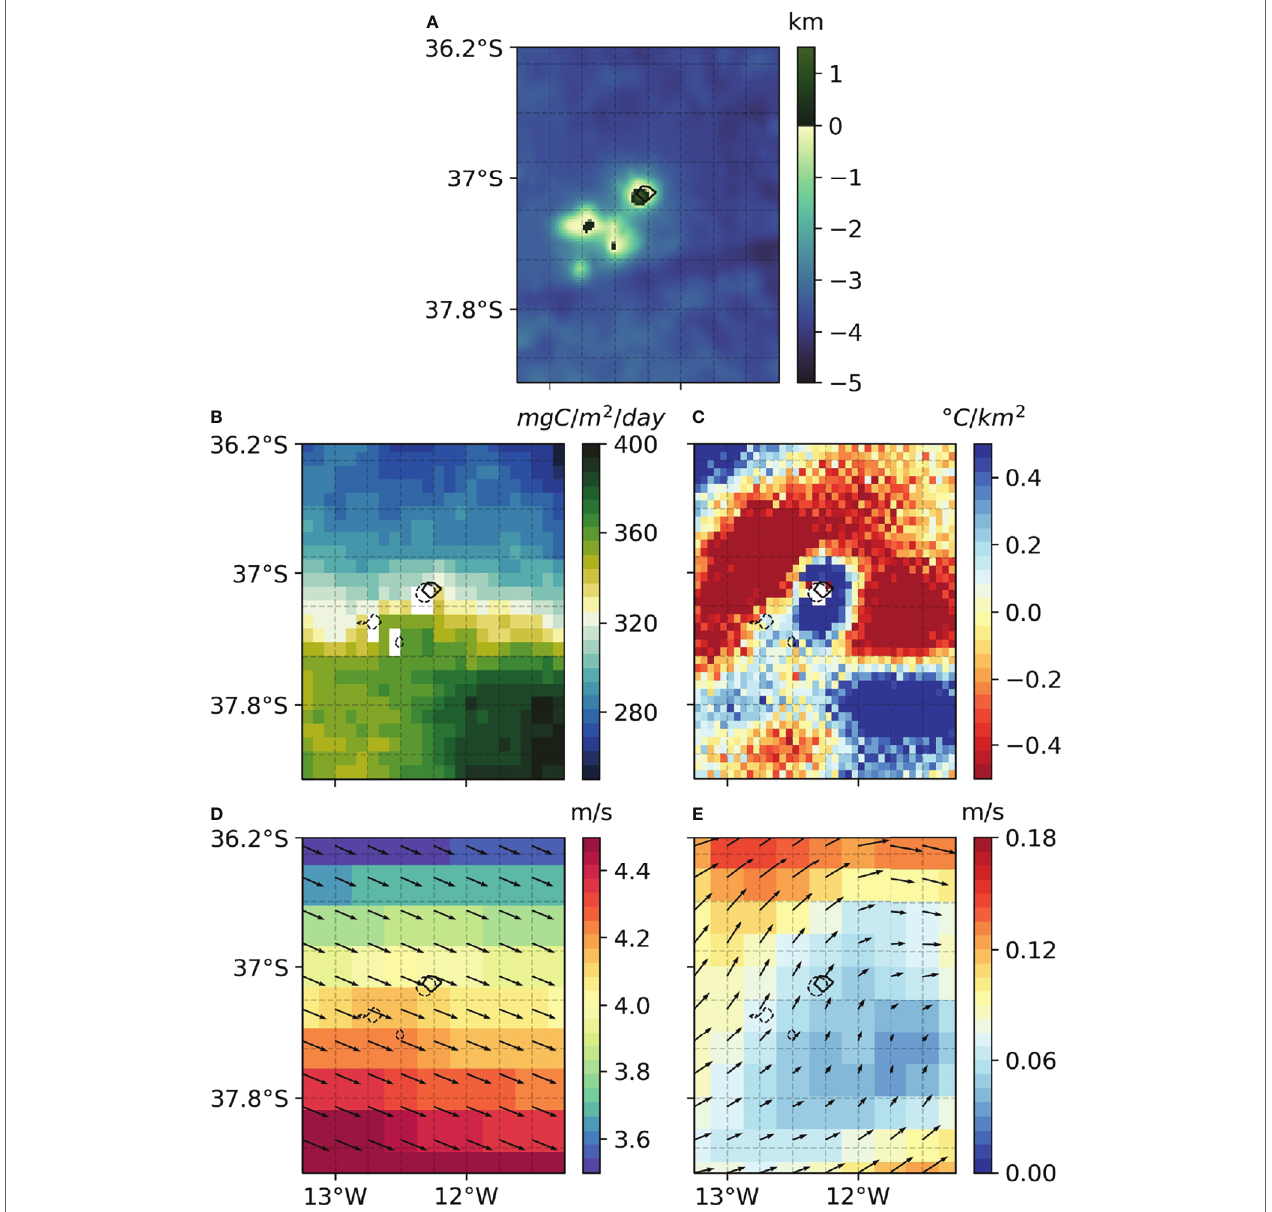
FIGURE 13 | Tristan da Cunha, (A) Topography, (B) NPP, (C) SST Laplacian, (D) Wind Speed, (E) Currents, annual average 2013. Black dashed line represents the 100 m depth